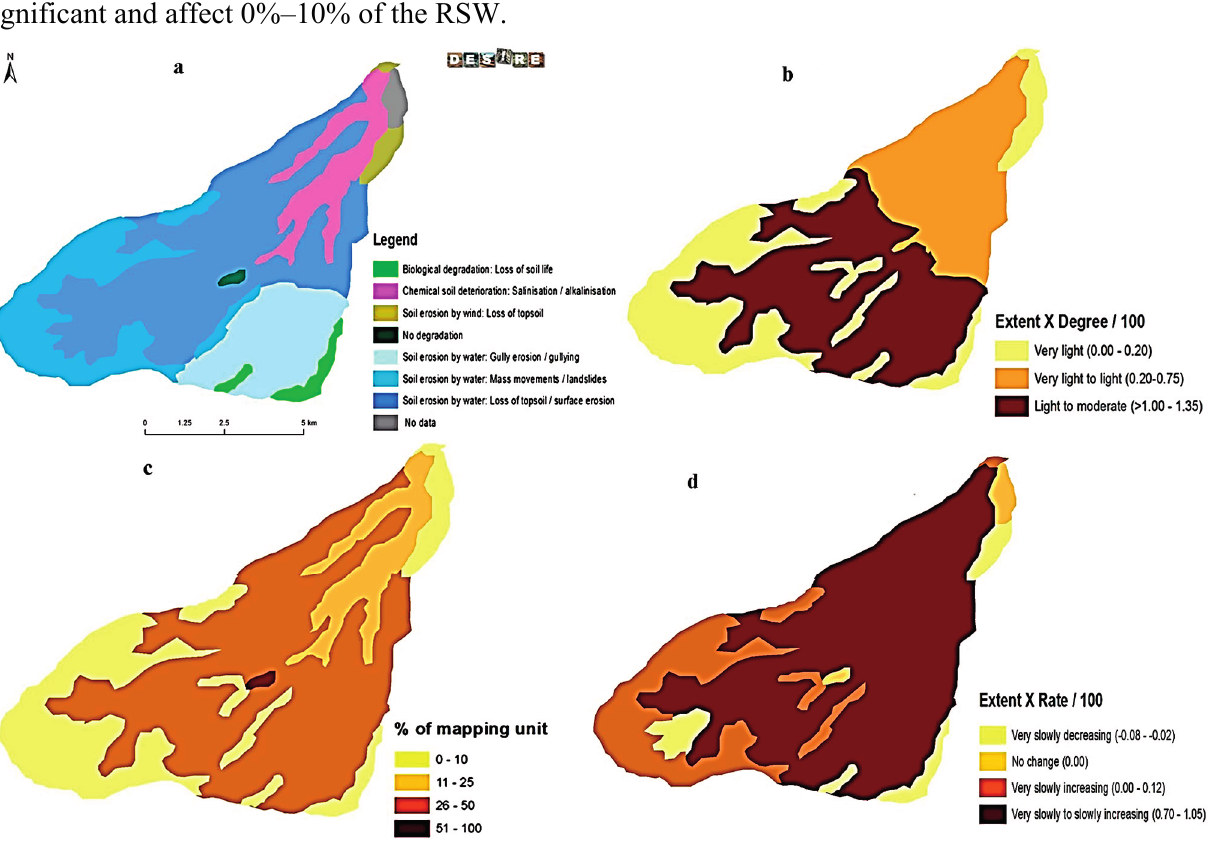
Figure 4. ( a ) Type, ( b ) degree, ( c ) extent and ( d ) rate of land degradation in the Ribeira Seca Watershed (RSW) on as the dominant type, moderate degree, and slight to moderate rate of degradation. Adapted from